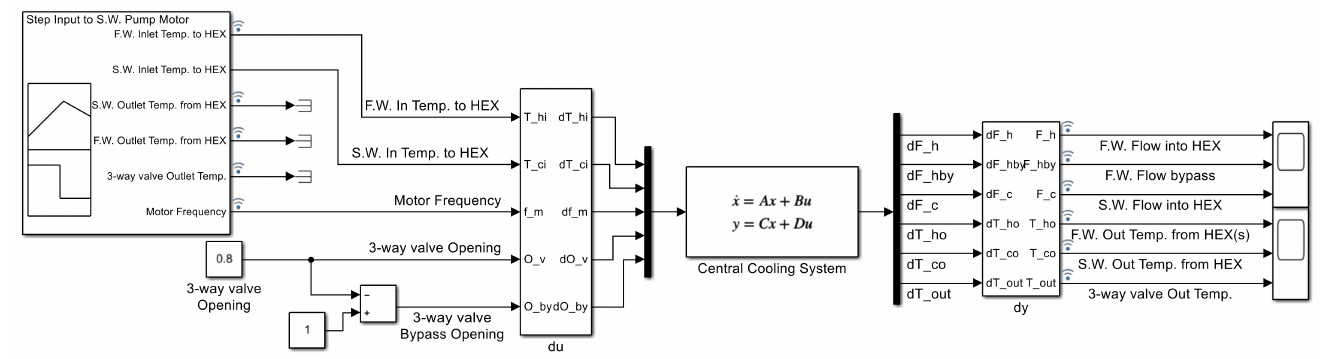
Figure 13. Configuration for step input for simulation. The 3-way valve opening was fixed at